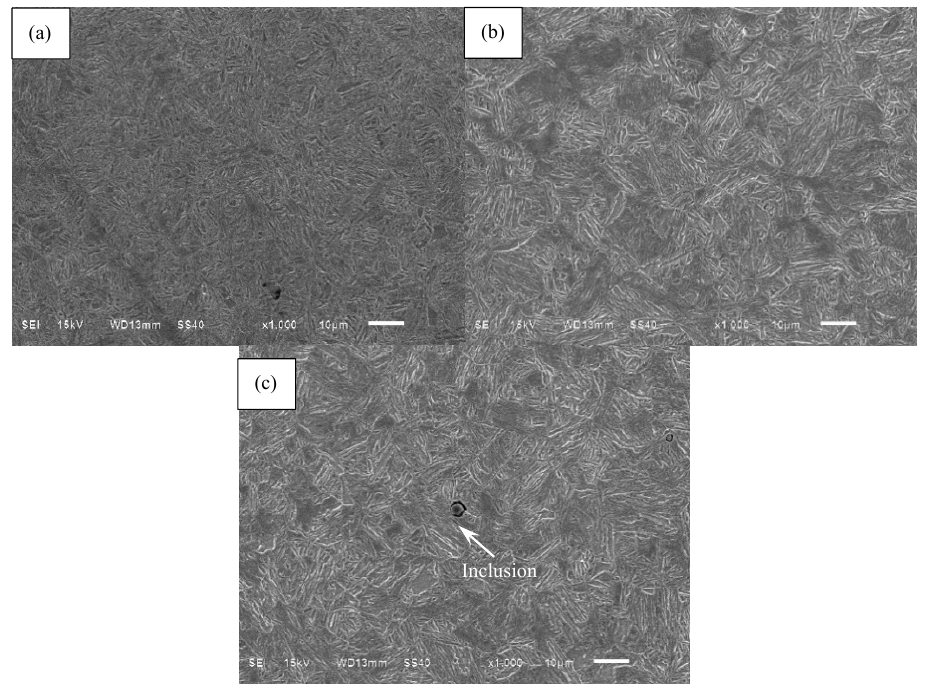
Figure 2. Microstructure observation of carburized Cr-Ni steel: ( a ) Microstructure in the carburized layer; ( b ) Microstructure in the core region; ( c ) Inclusion.